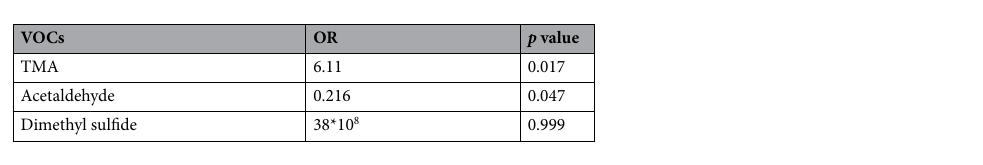
Table 3. Logistic regression test and more significant odds ratio among VOCs tested. OR odds ratio; TMA trimethylamine; VOCs volatile organic